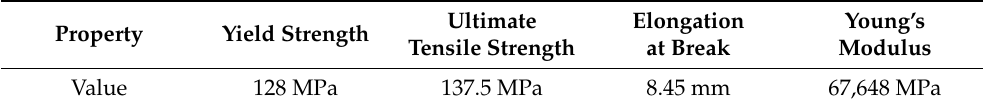
Table 2. Mechanical properties of Al 1050.